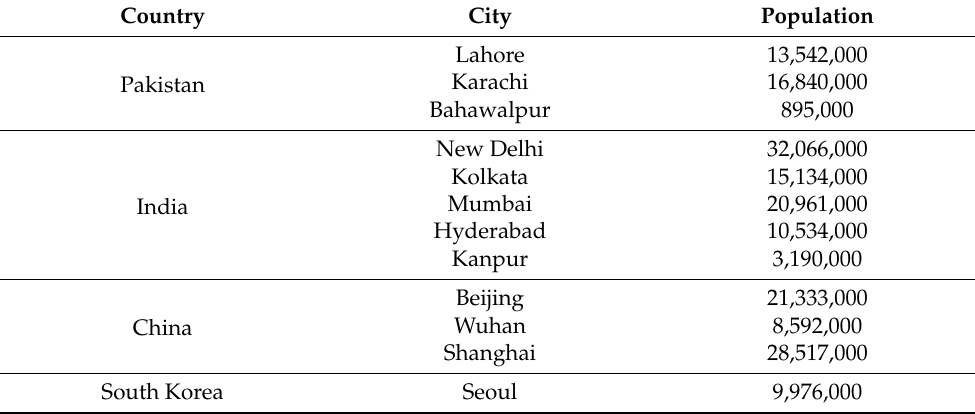
Figure 1. Eleven-year mean (2010–2020) of OMI-retrieved global tropospheric NO 2 column density in 10 15 molecules/cm 2 at the 12 locations included in this study (marked with boxes). Table 1. Population sizes of the cities selected for the current research.